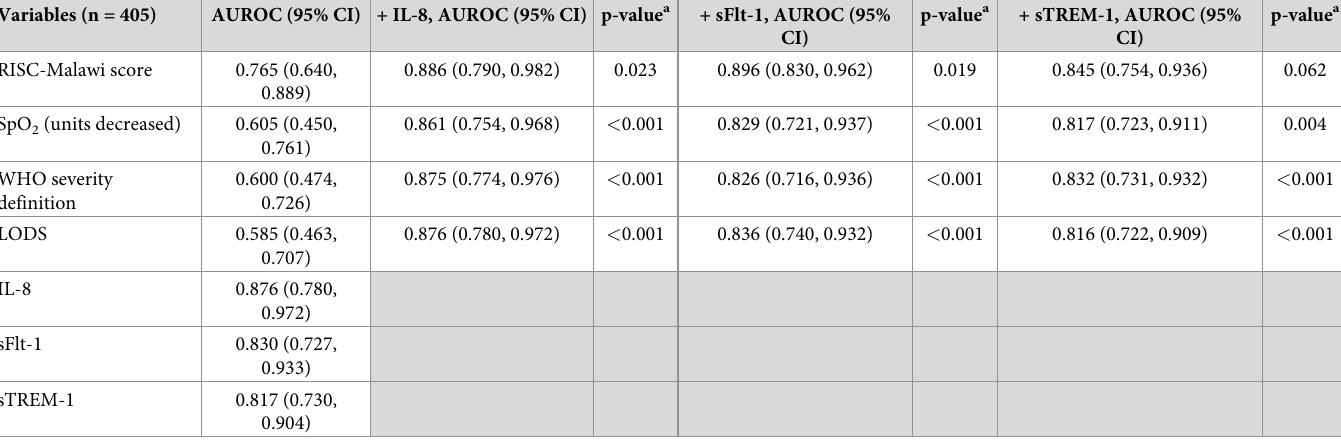
a AUROCs comparison of the models with a clinical parameter alone versus the models with the same clinical parameter combined with either IL-8, sFlt-1, or sTREM-1. p-values were computed using the algorithm suggested by DeLong et al . [34].